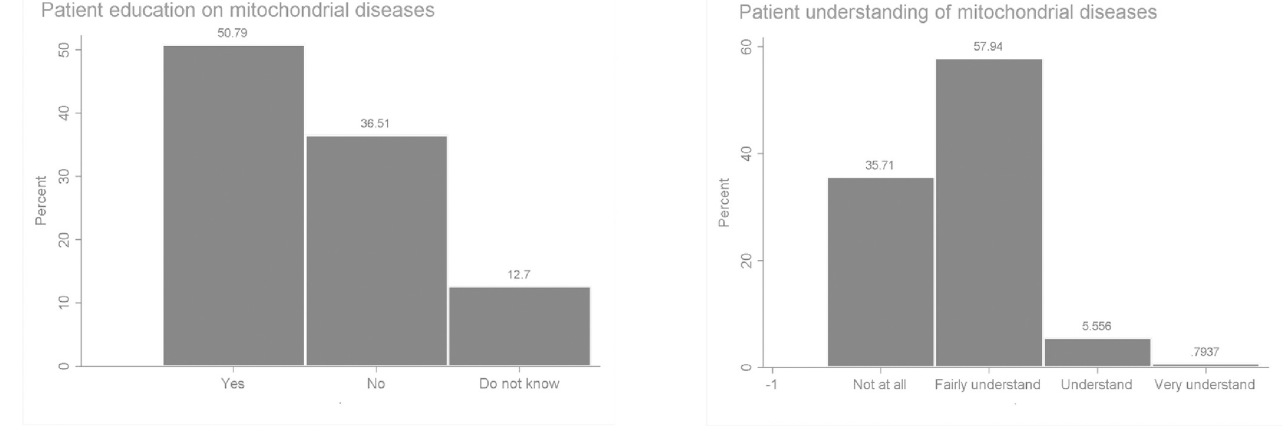
Fig 4. Patient education and level of understanding of mitochondrial diseases.